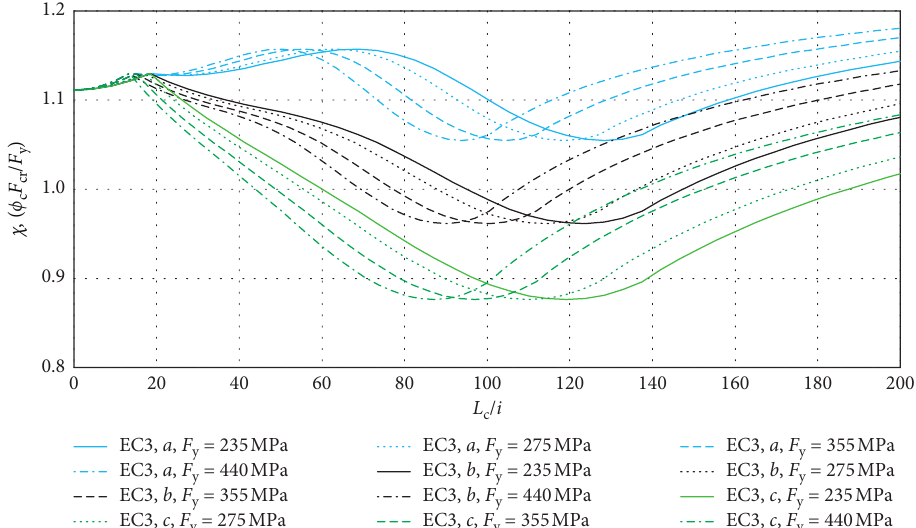
c /i ) for two different F y values (235 and 440MPa).